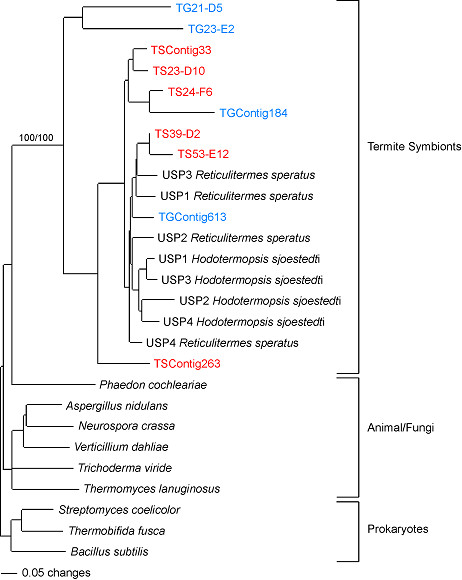
Protein neighbor-joining phylogeny of glycoside hydrolase family 11 (GHF11). The tree was rooted with bacterial GHF11 enzyme sequences and showed that all GHF11 transcripts generated during this study clustered with GHF11 genes previously sequenced from termite symbionts (uncultured symbiotic protist (USP)). The transcripts identified in the termite gut (TG) library are shown in blue, whereas the transcript sequences that originated from the termite symbiont (TS) library are shown in red. Numbers (100/100) above the node represent bootstrap support (1000 replicates). For clarity purposes only relevant bootstrap values are indicated.